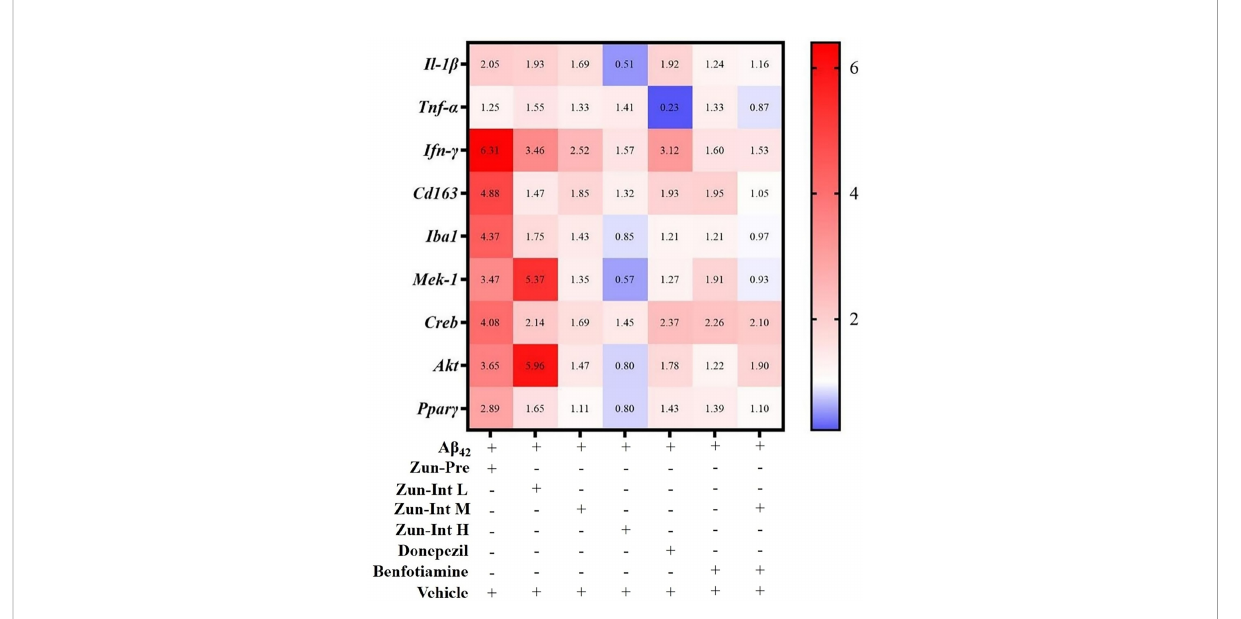
FIGURE 5 Effect of drugs on mRNA expression levels. AD model group (A b 42) fold change was de fi ned as 1, compared with AD model mice fold change higher than 2 was de fi ned as upregulation and less than 0.75 as